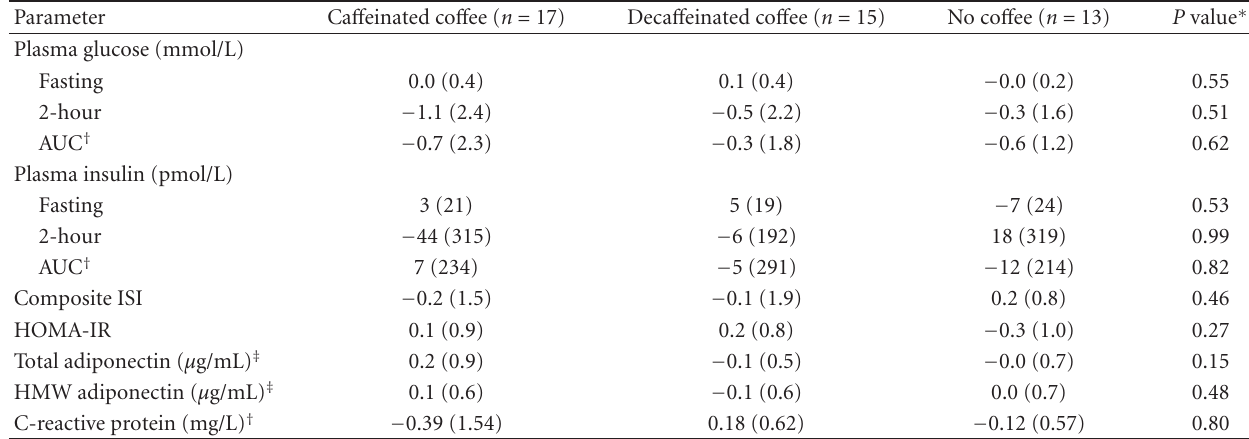
Table 2: Mean changes of glucose metabolism parameters and serum adiponectin and C-reactive protein at 8 weeks of intervention as compared with the baseline values.